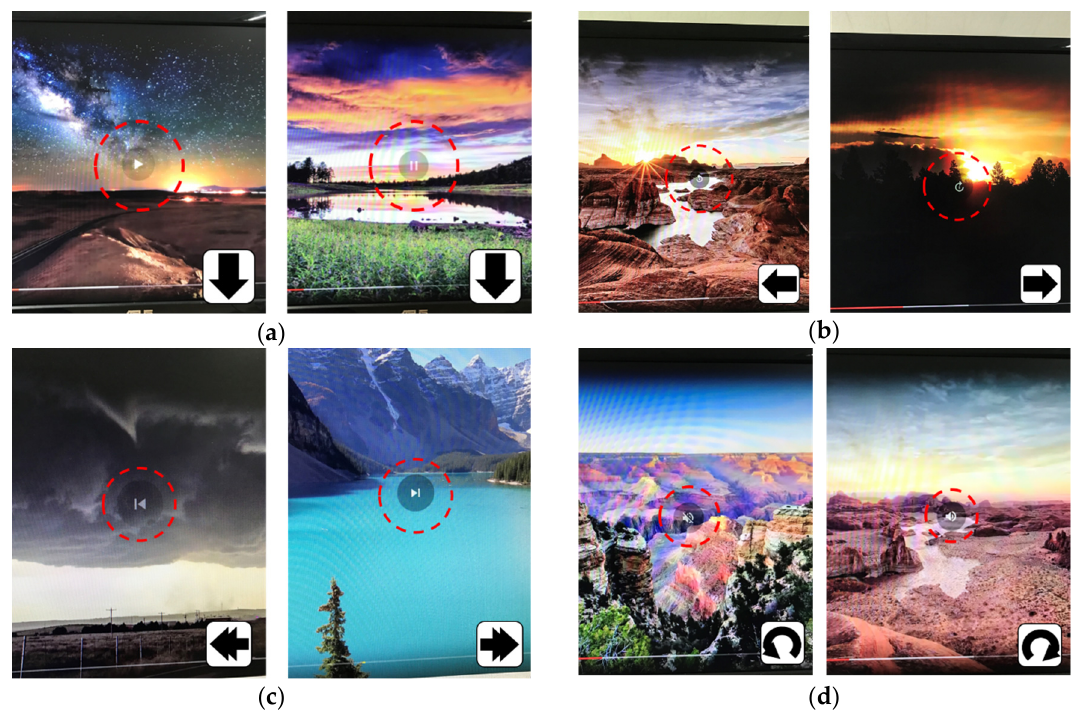
Figure 7. Sequence of experiments using gestures as input to a multimedia video player. ( a ) Playing and pausing functions, ( b ) time-shifting, either rewinding (left) or fast-forwarding (right), ( c ) playing previous (left) or next file in a playlist, ( d ) volume down (left) or up (right).